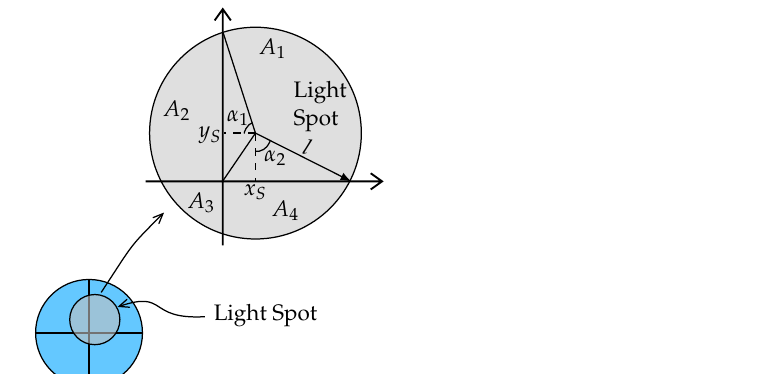
Figure 1. Structure of QADA.